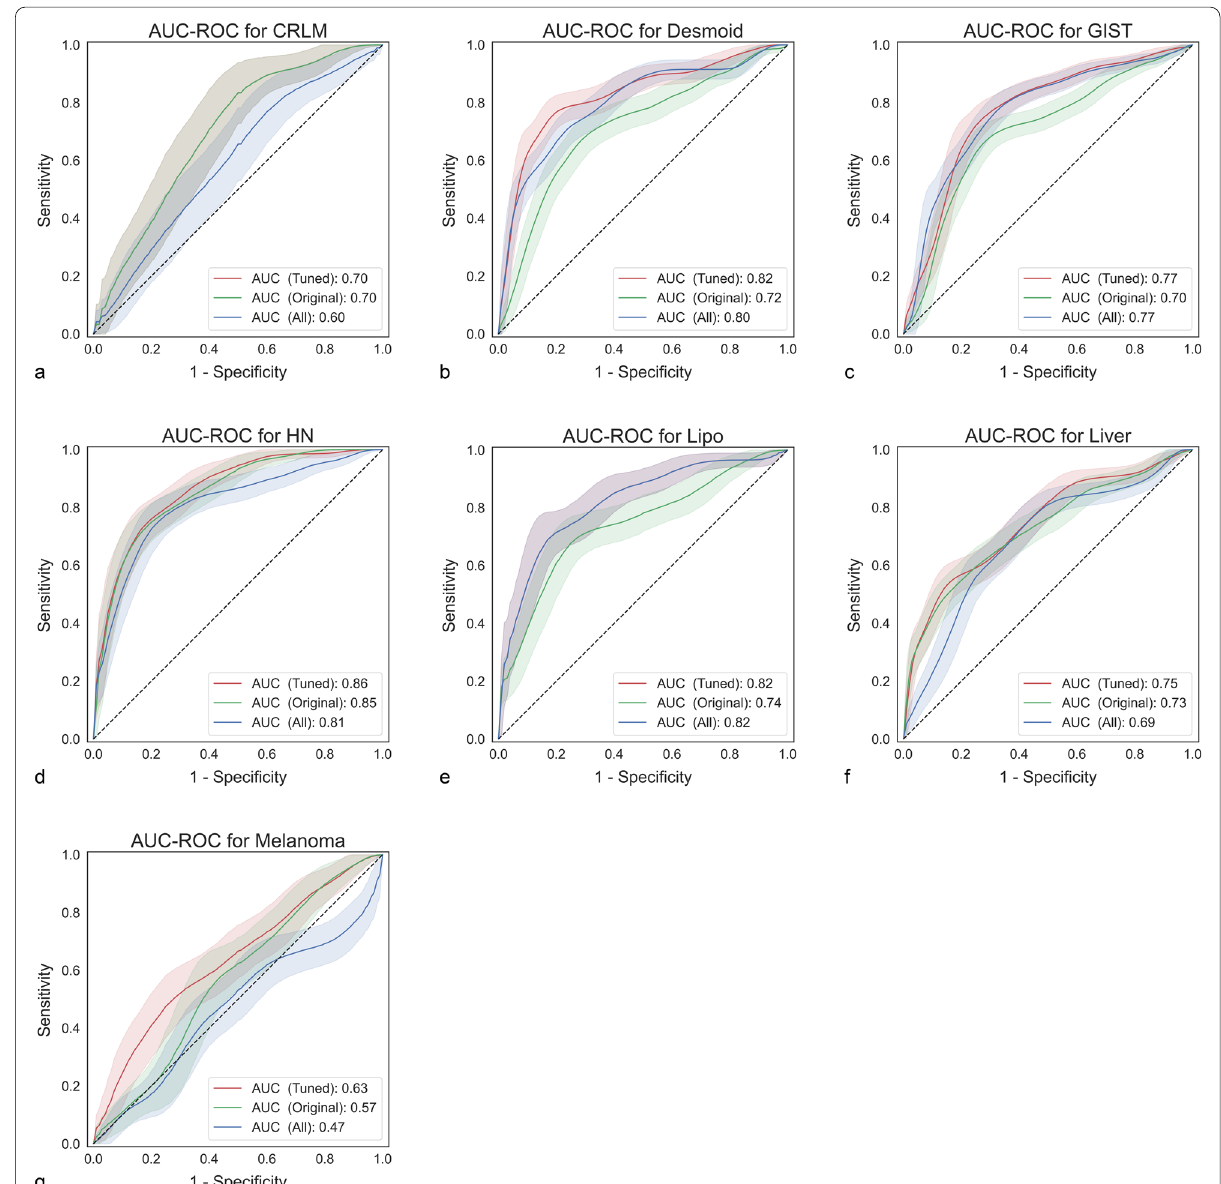
Fig. 2 Receiver operating characteristic curves for all datasets. Tuned denotes the best-performing preprocessing filter and can differ for each dataset. Note that in the case of CRLM dataset, the best preprocessing filter set was the original set; therefore, these curves